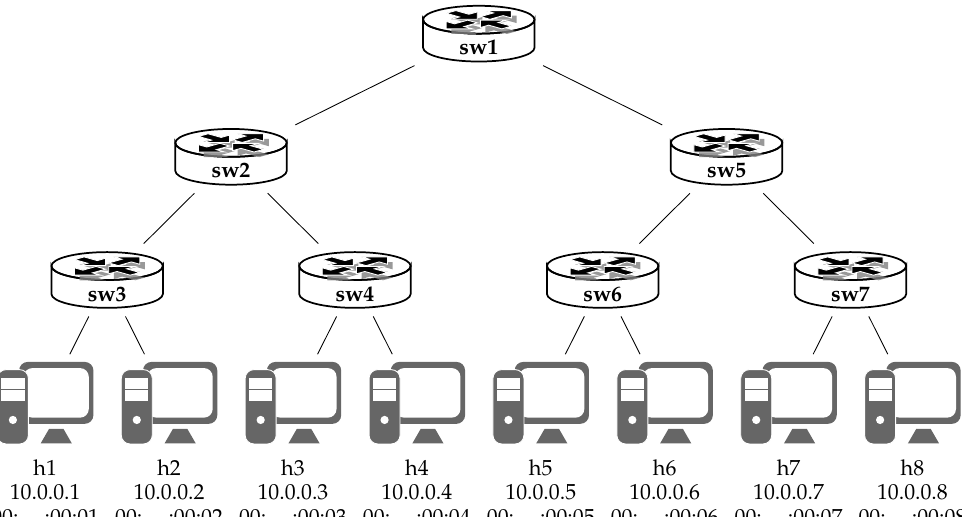
Figure 11. Tested